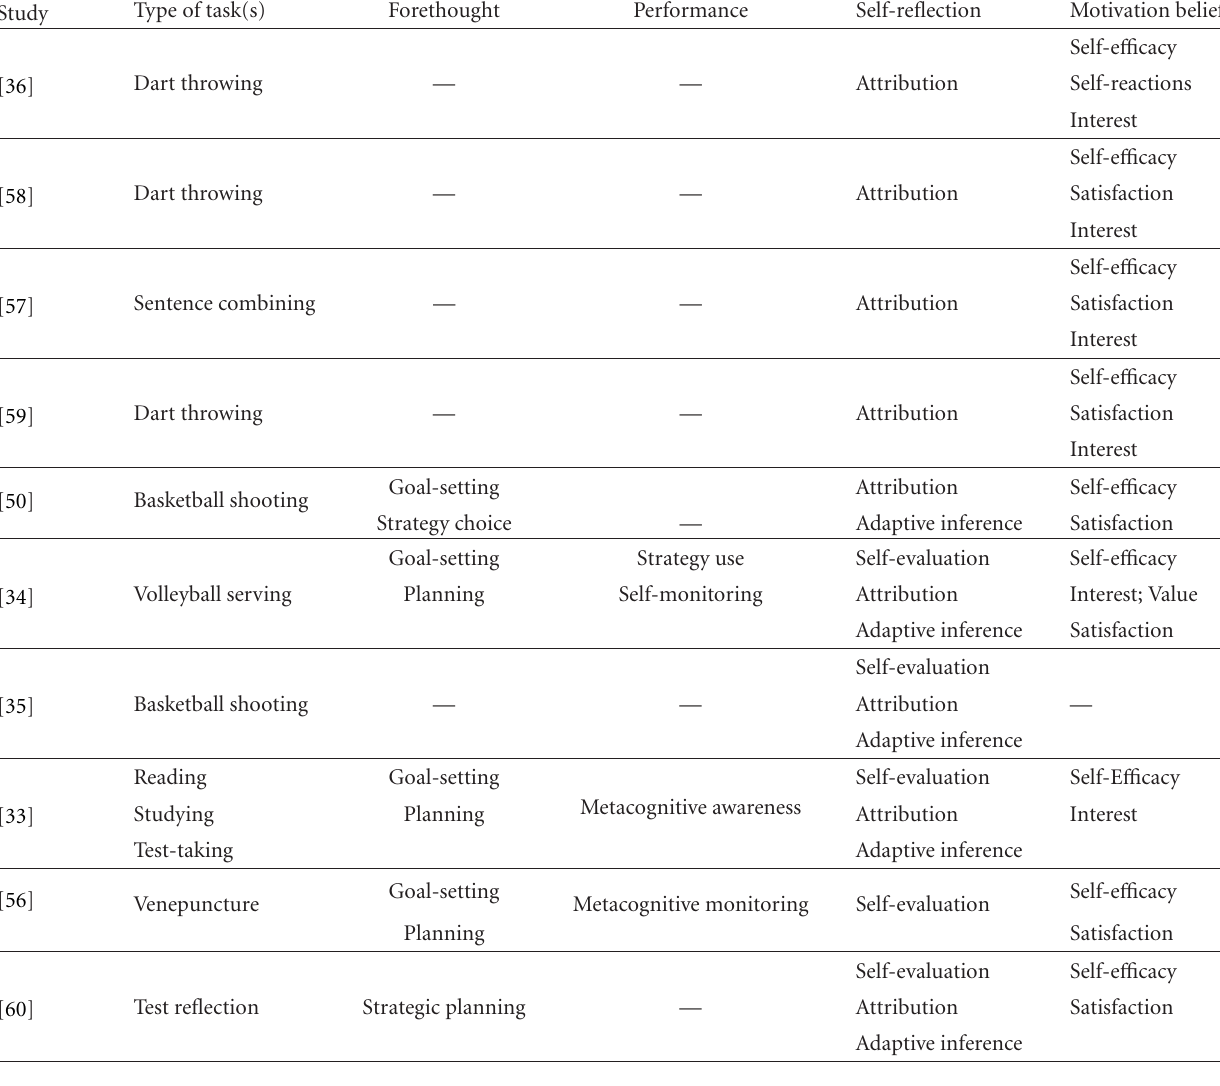
Table 1: SRL microanalytic studies targeting cyclical phase regulatory processes and motivation beliefs.